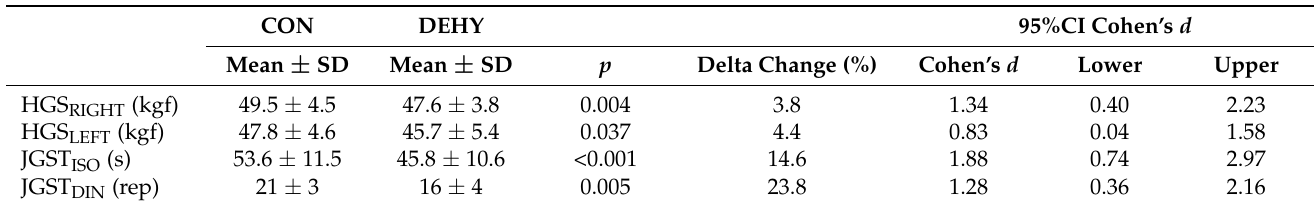
Table 2. Physical performance and physiological responses in the CON and DEHY conditions CON DEHY 95%CI Cohen’s d Mean ± SD Mean ± SD